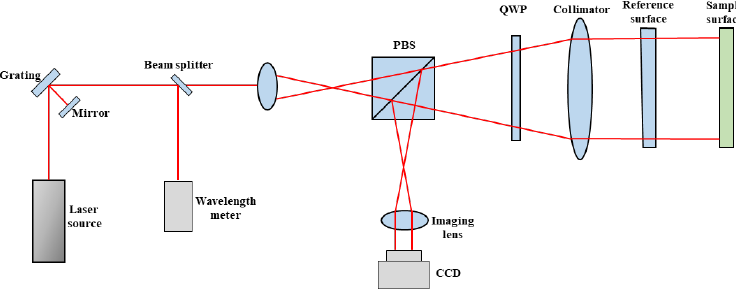
Figure 1. The setup of the wavelength-tuning Fizeau interferometer. PBS, Polarizing beam splitter; QWP, Quarter wave plate; CCD, Charge Coupled Device.